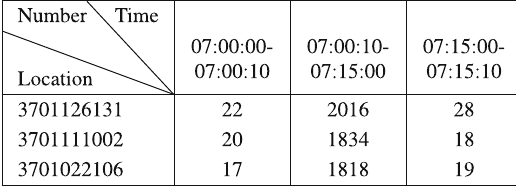
Table 3 Coordinator node maintains the records